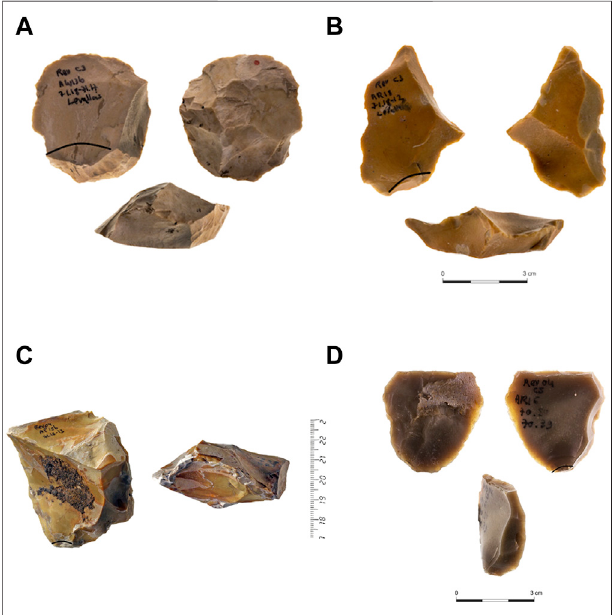
FIGURE 9 | (A,B) Éclats débordants CTEs from Revadim. (C) Outrepassé CTE from Revadim. Note that this item may have been